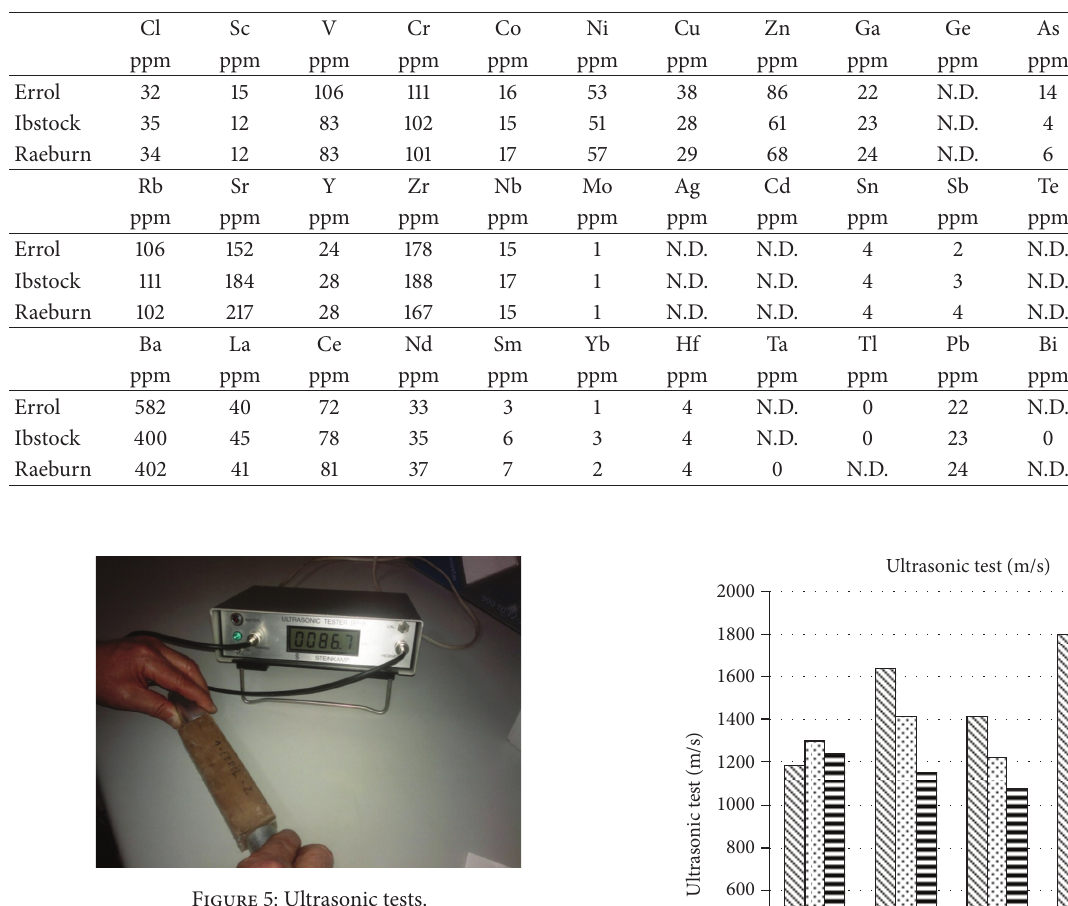
Table 5: Chemical composition of three soils (main elements and traces).